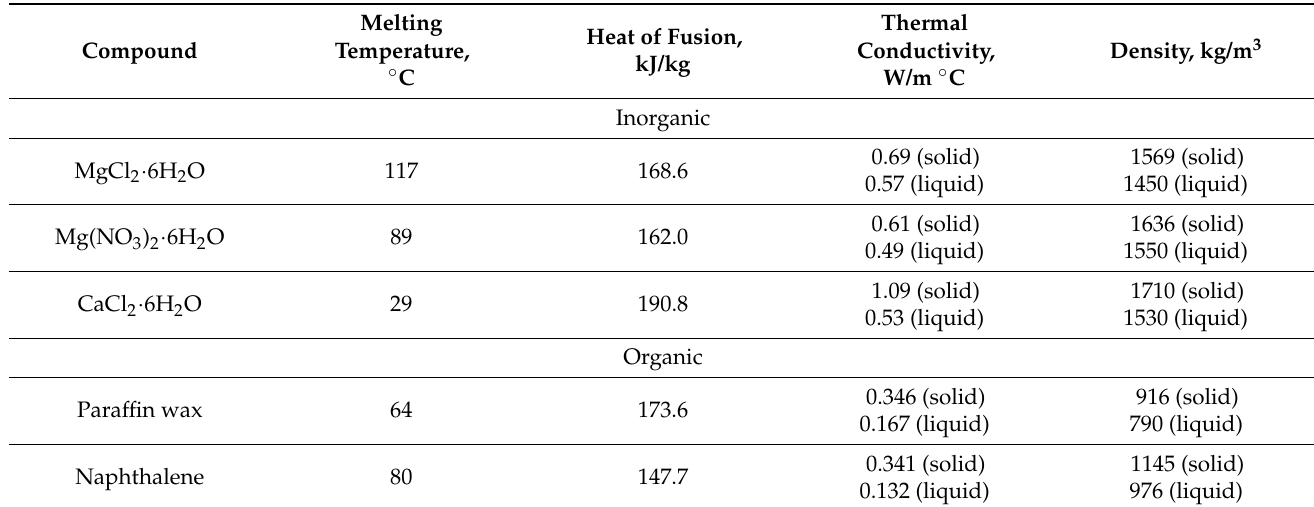
Table 1. Thermophysical properties of some Phase change materials (PCMs) [9,10,12,13].